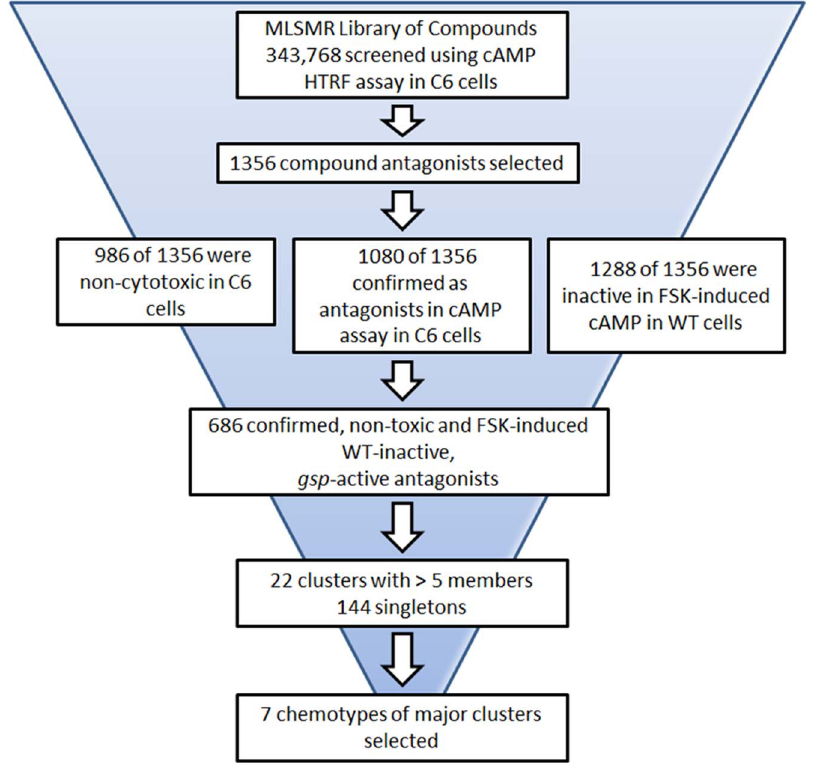
Figure 1. Compound Identification Flow Chart. Depicted is a flow chart of the assays, filtering, and analyses that were performed to ultimately identify the 7 chemotypes of clusters of molecules that have been selected for further study.